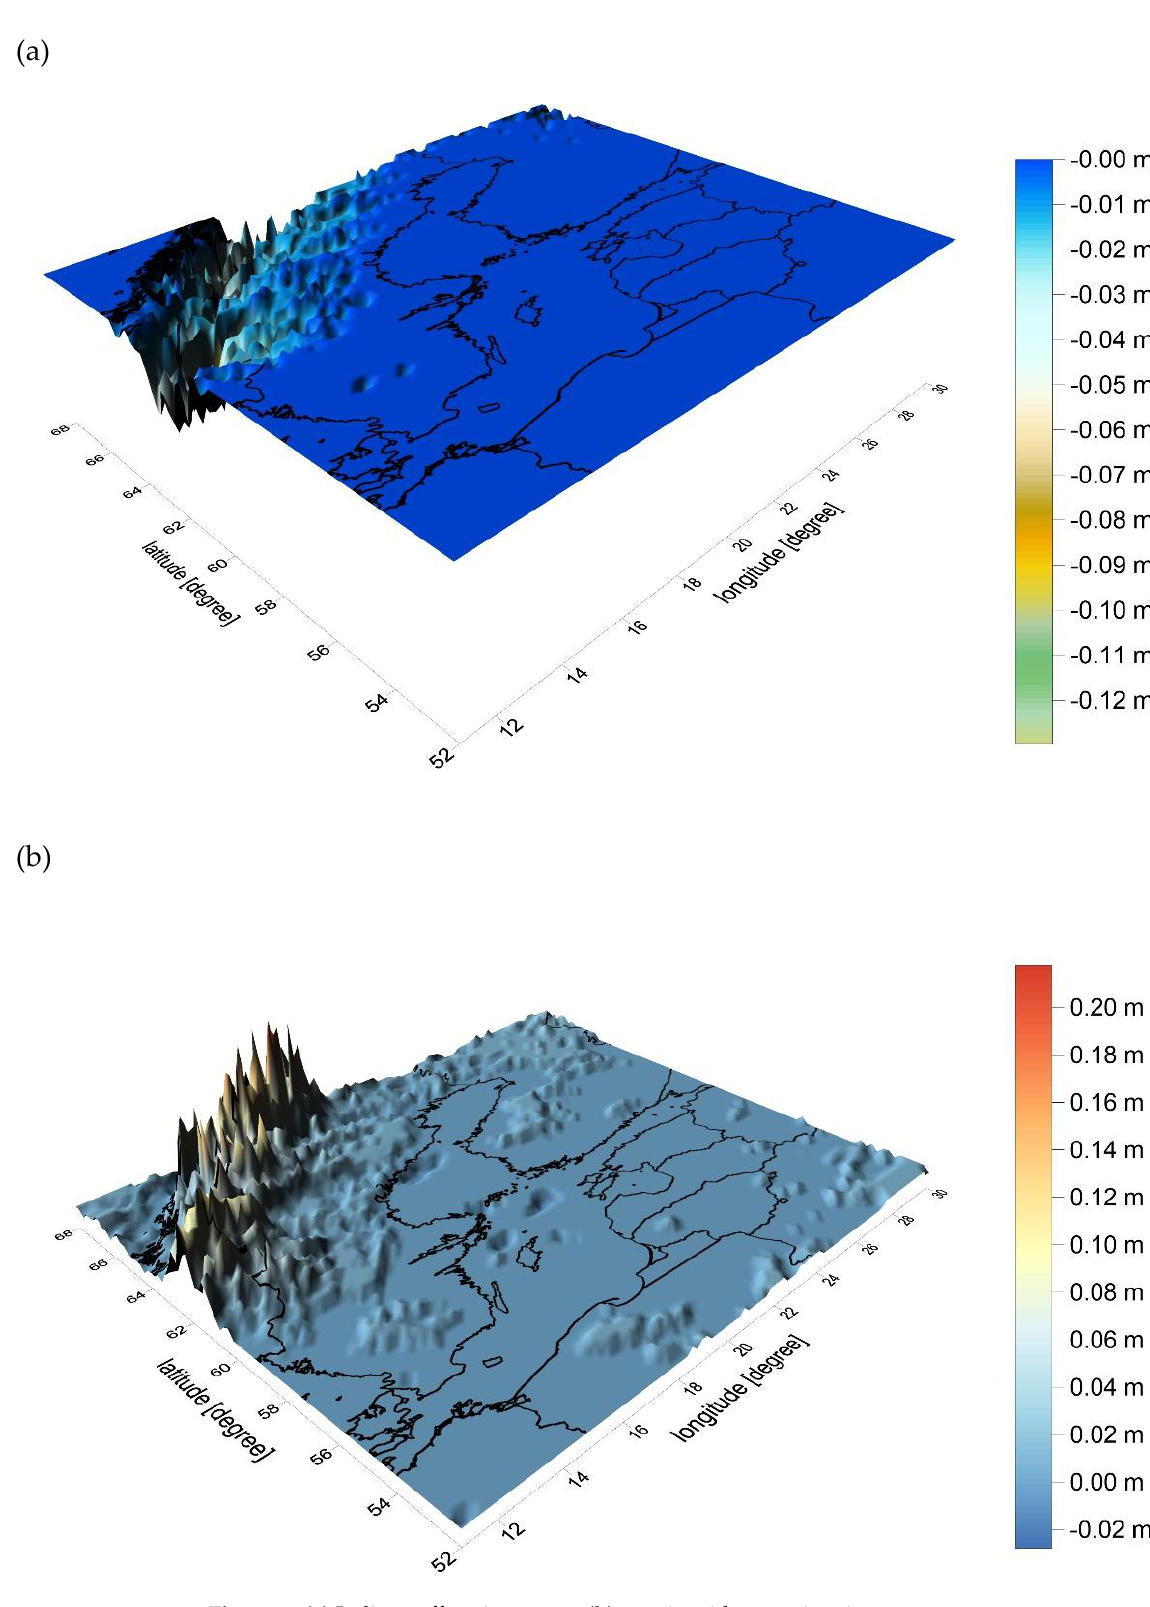
Figure 8. ( a ) Indirect effect, in meters; ( b ) quasigeoid correction, in meters.